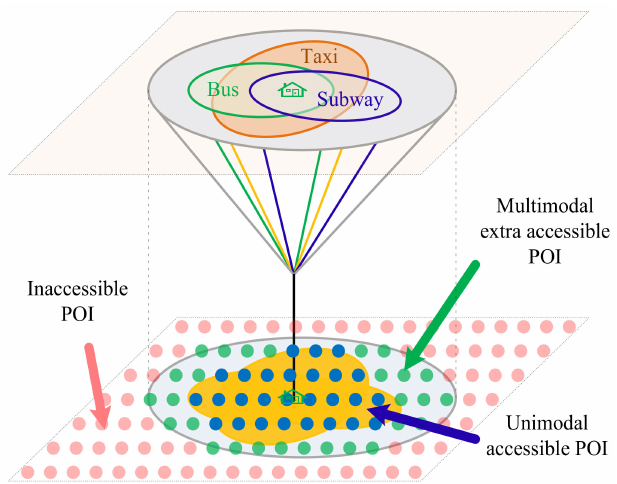
Figure 7. Advantages of multimodal